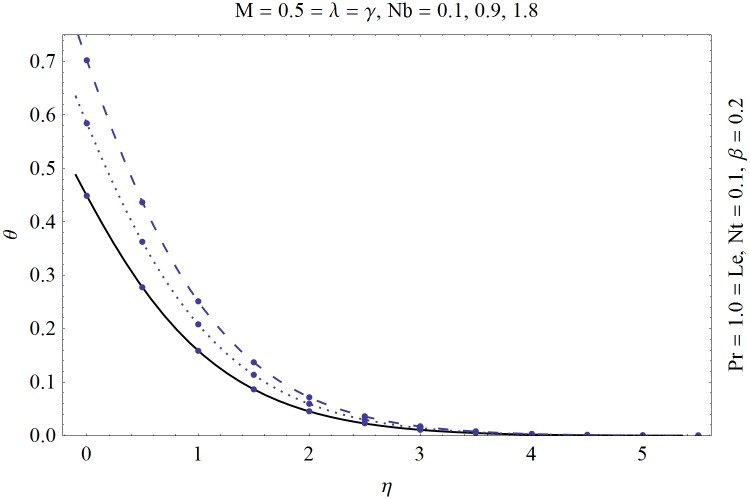
Comparison of analytic (solid line) and numeric (dots) solutions for temperature.